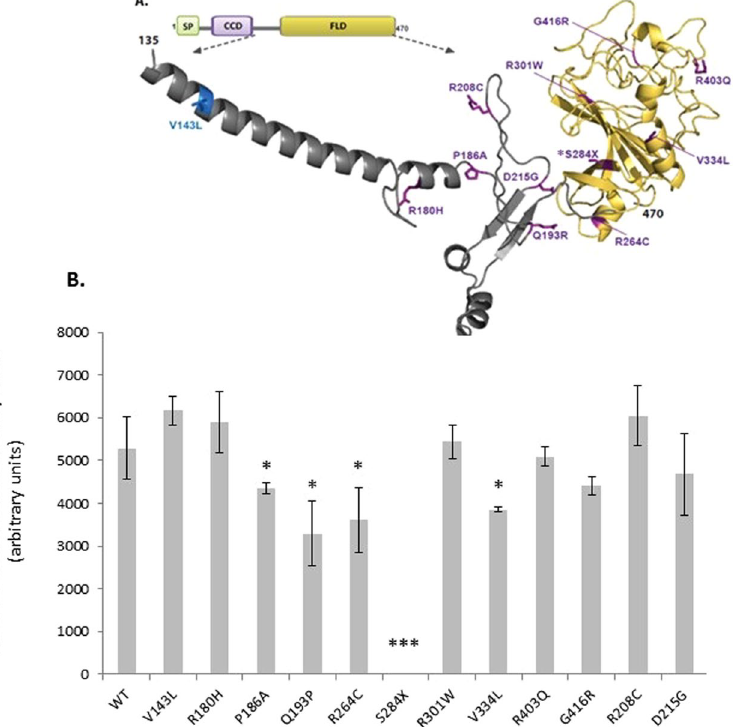
Figure 4. Functional characterisation of ANGPTL6 variants location and functional effect ( A ) Human ANGPTL6 protein and location of the genetic variants. Schematic of the human ANGPTL6 protein with the three recognisable domains: signal peptide (SP) in green, coiled-coil domain (CCD) in purple, and fibrinogen- like domain (FLD) in yellow. As all genetic variants identified are located predominantly in the FLD, the partial tertiary structure of the C-terminal protein portion (amino acids 135–470), based on previously solved fibrinogen structure (1lwu) is presented. The single variant seen in controls only is shown in blue, variants identified in cases are in purple, the S284X variant is starred. ( B ) Functional characterisation of ANGPTL6 variants. Cells were transiently transfected with constructs encoding wild-type (WT) or mutant ANGPTL6; levels of protein secretion into the media were measured by ELISA; means + / − standard deviation (SD) for experiments performed in triplicate are shown (results were confirmed by Western blotting; data not shown). Statistical significance was measured using unpaired T-test with Welch’s correction using the GraphPad Prism software. * p < 0.05; *** p <